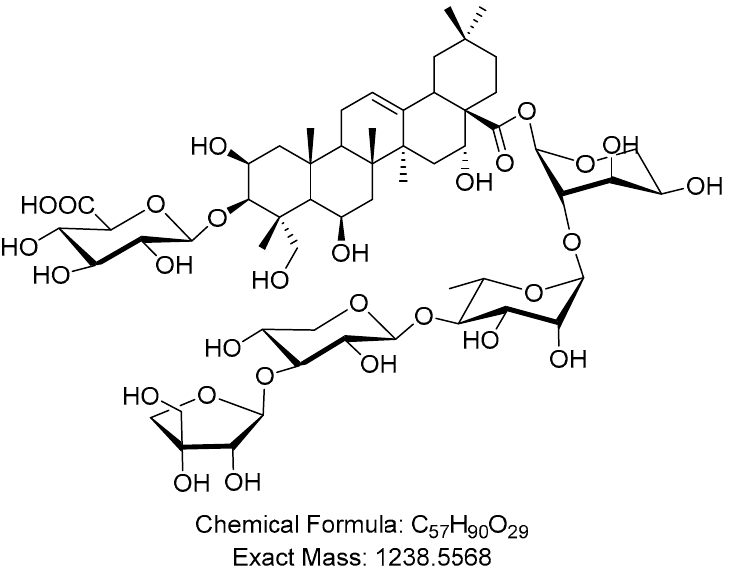
Figure 1. Chemical structure of Butryoside D, chemical formula of C 57 H 90 O 29 and an exact mass of 1238.5568.